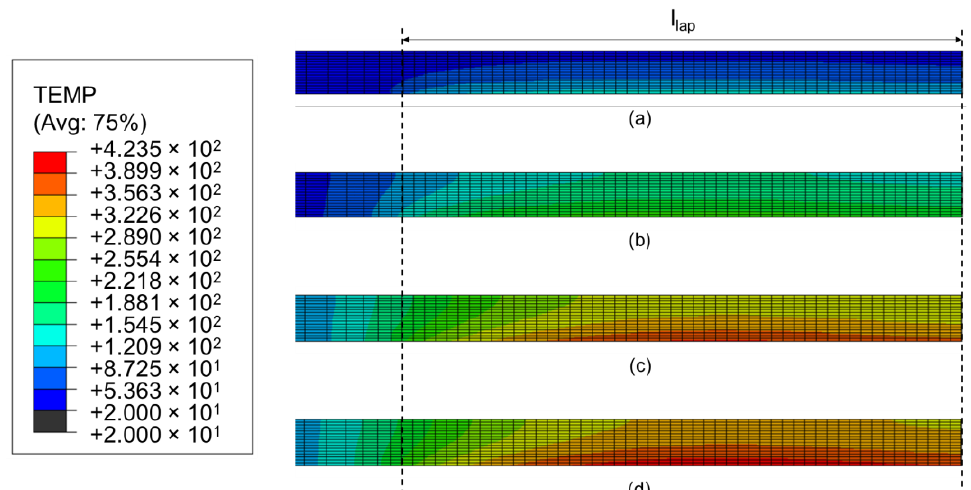
Figure 4. Temperature distribution in °C in the joining zone for an input power of 60 kW/m 2 at ( a ) 3 s, ( b ) 10 s, ( c ) 20 s, and ( d ) 25 s.